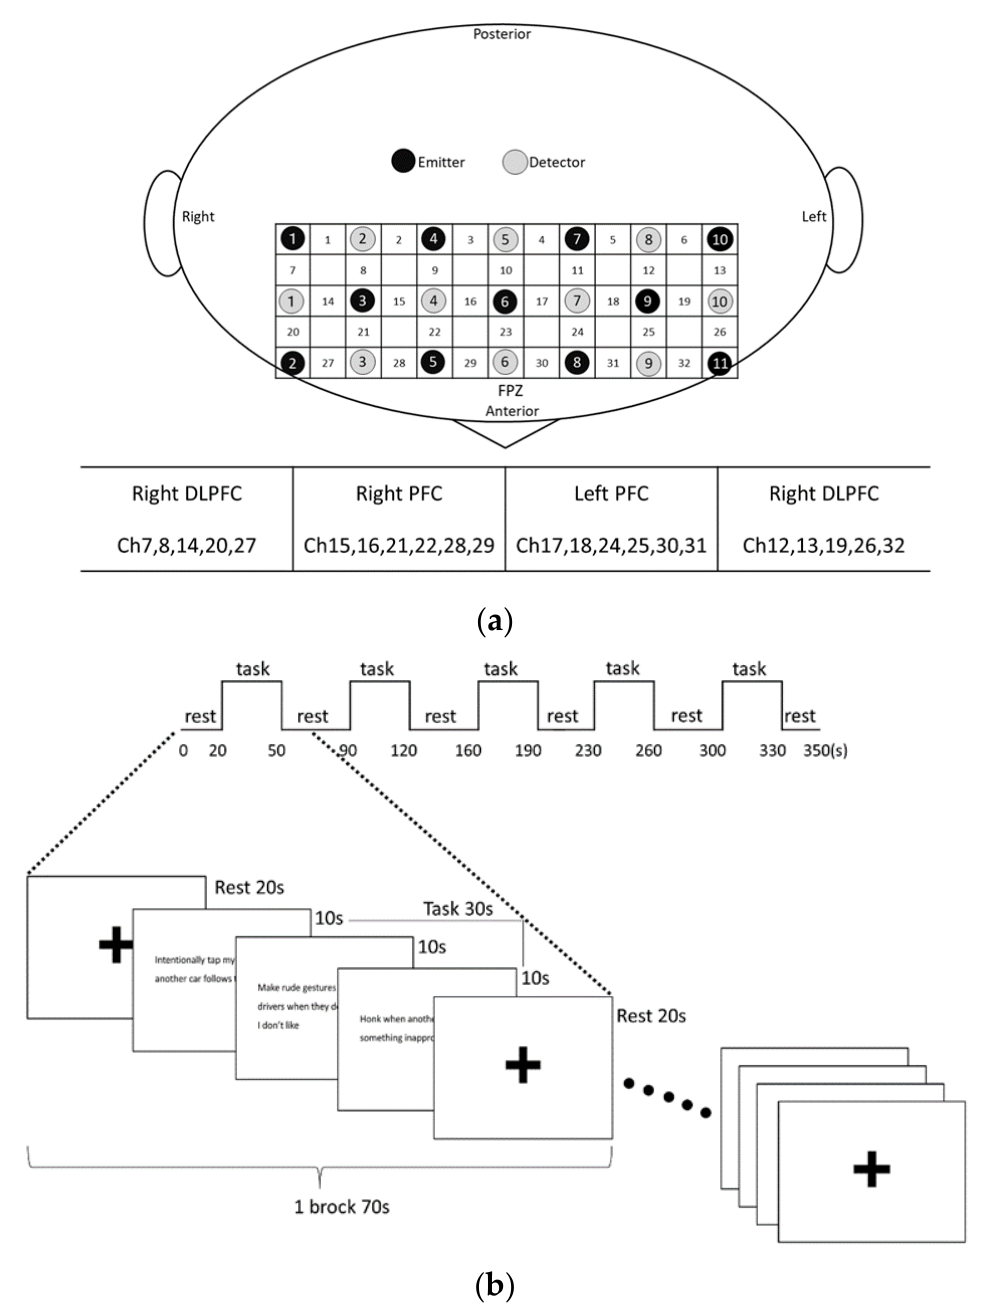
Figure 1. Experimental design. ( a ) Channel arrangement and areas of interest (DLPFC; Dorsolateral prefrontal cortex, PFC; Prefrontal cortex); ( b ) protocol and task design.